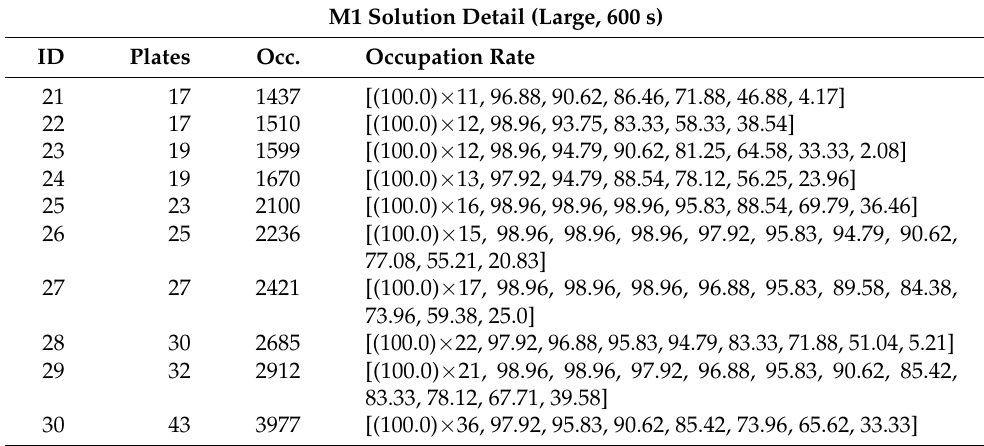
Table A13. M1 solutions detailed for large files, limited to 600s.